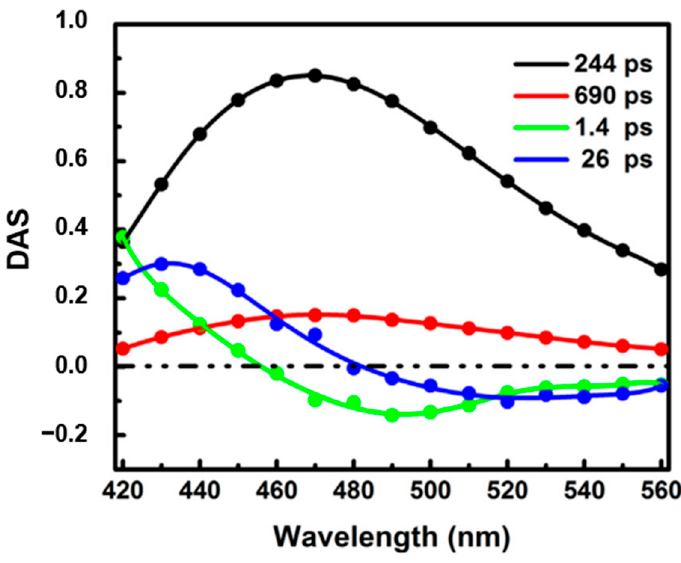
FIGURE 10 Figure 10. Decay associated spectra of free NADH in Tris-buffered solution (pH 7.35). Image repro- duced from Chemical Physics Letters 726 (2019)